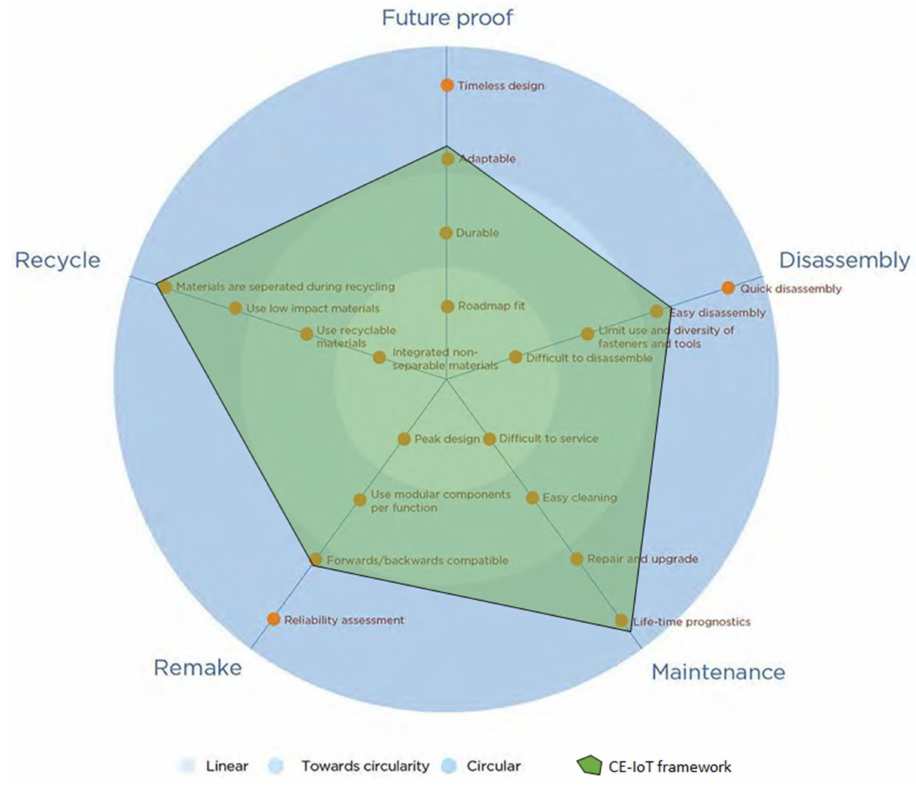
Figure 6. The CE-IoT spider